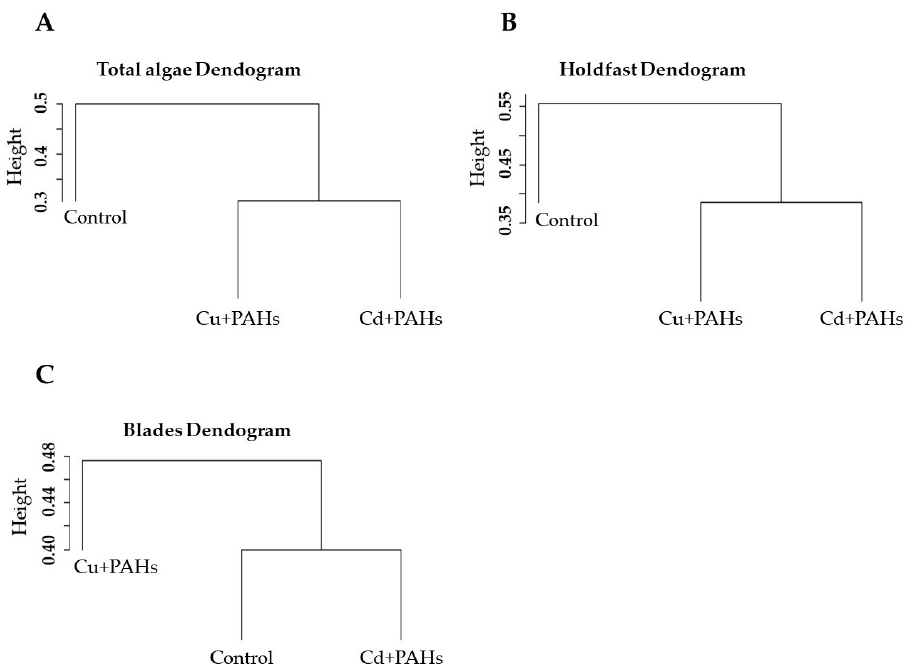
Figure 5. Dendrogram of the Jaccard similarity coefficient for the fauna associated with Macrocystis pyrifera . ( A ) Total algae, ( B ) holdfasts, and ( C ) blades. The values are in a range from 0 to 1.